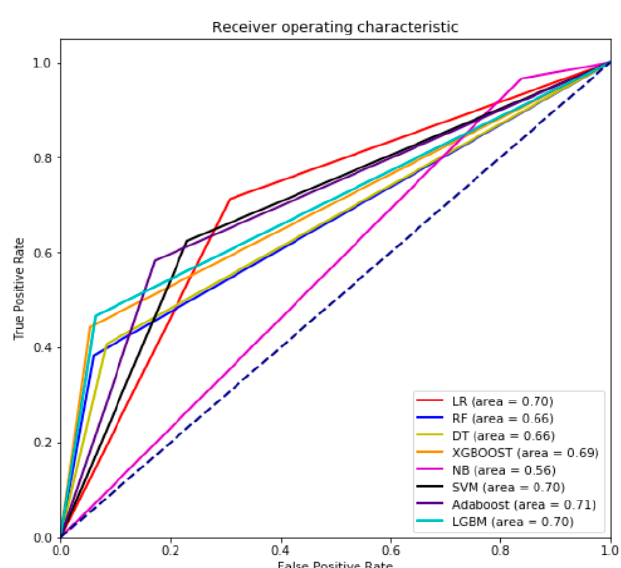
Figure 7. AUROC curve of the single models.